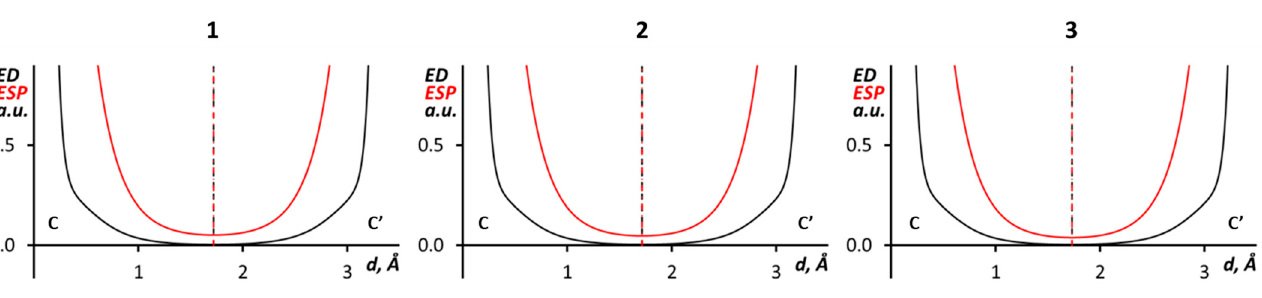
Figure 10. The ED and ESP 1D profiles along the C ··· C’ bond paths for the ( 1 ) 2 (left), ( 2 ) 2 (middle), and ( 3 ) 2 (right) dimeric clusters of type II.